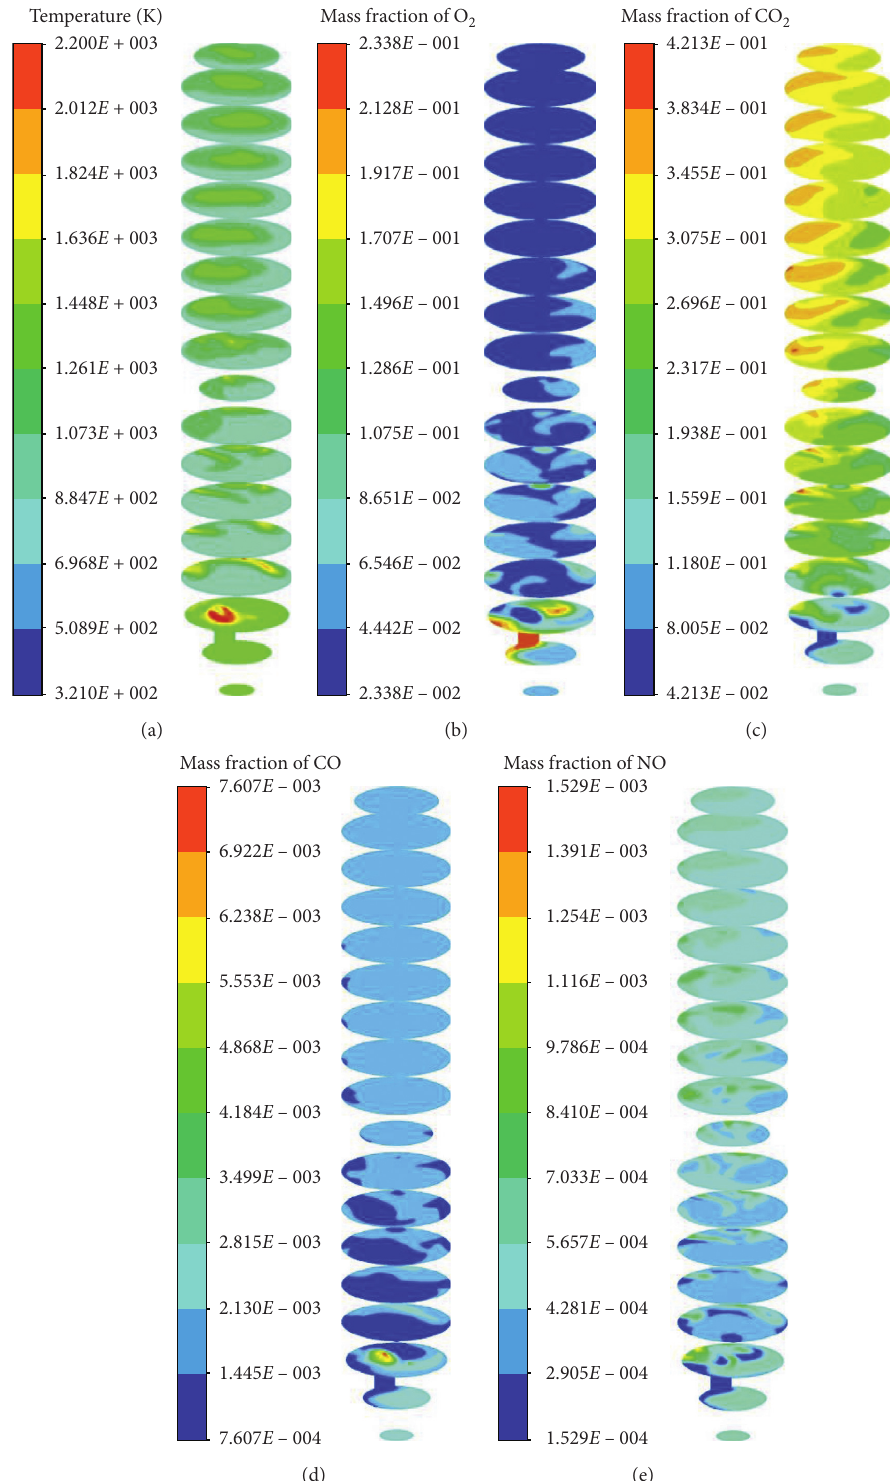
2 . (c) CO 2 . (d) CO. (e)